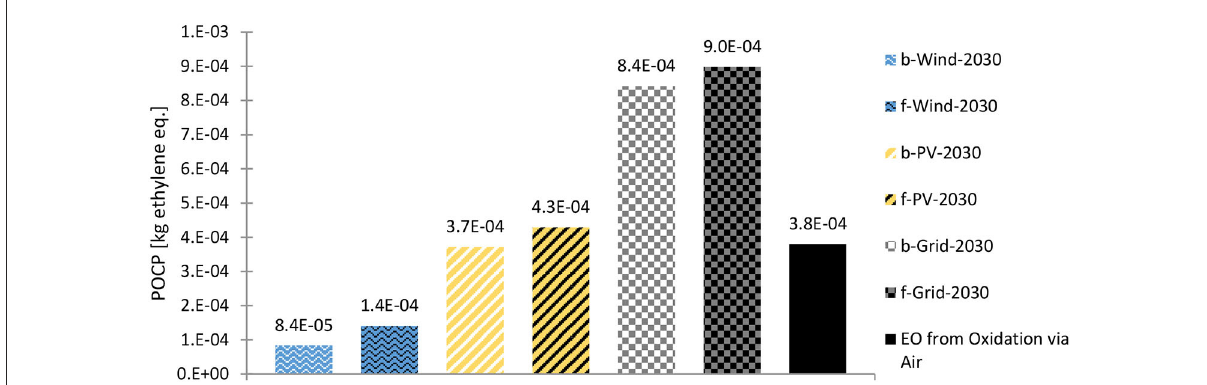
FIGURE11 POCP of the 2030 scenarios (biogenic CO 2 = b; fossil CO 2 = f) with reduced ethylene (and methane) loss and the fossil benchmark. Source: own data and illustration except for data of EO from Oxidation via Air, which are taken from (GaBi sphera,